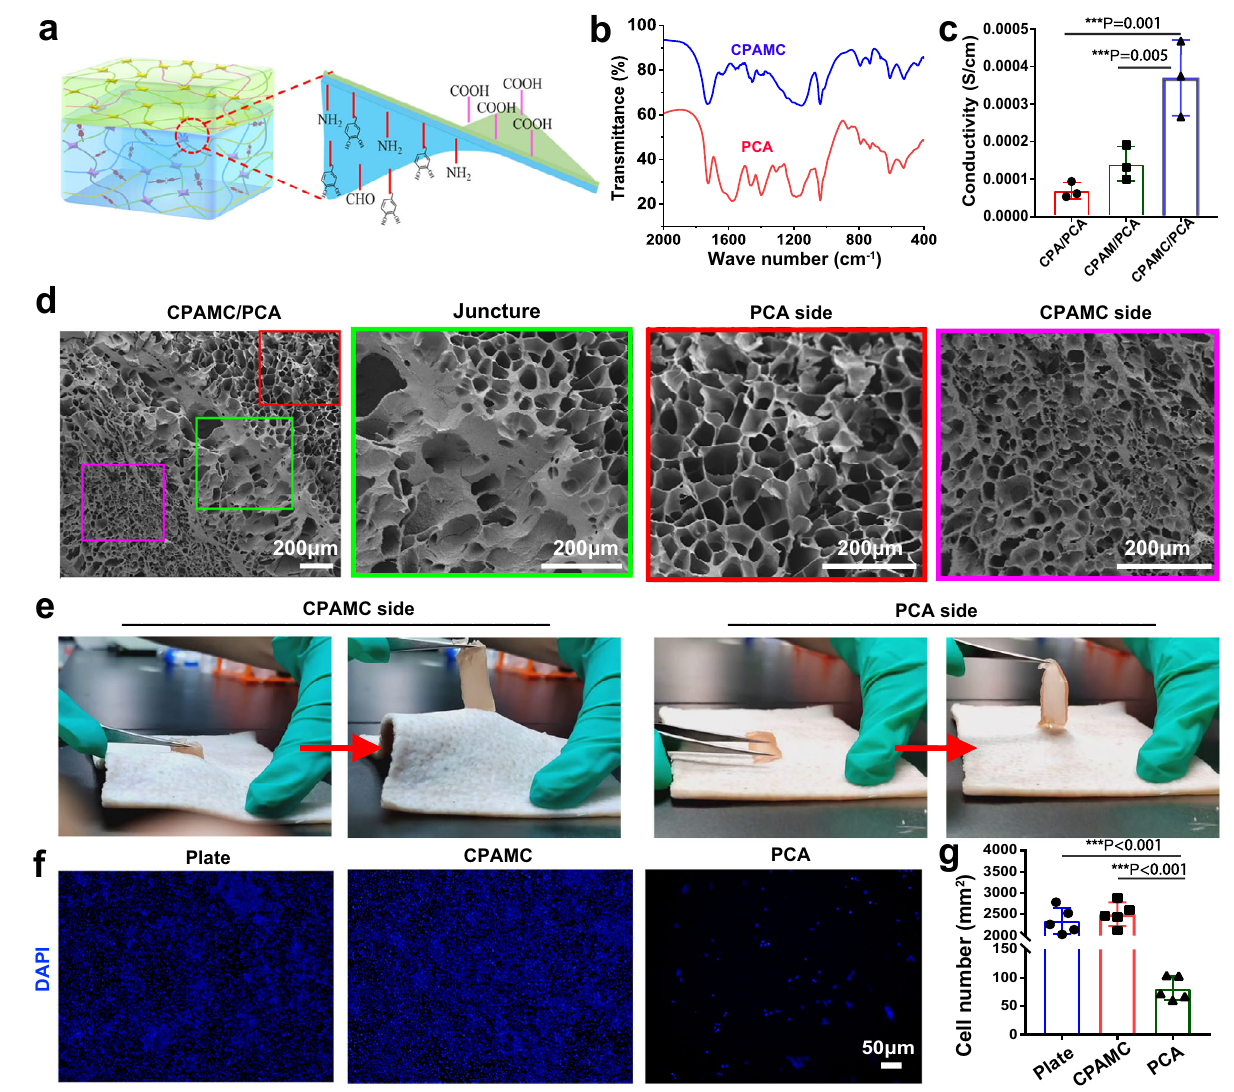
Fig. 4 | Performances test of CPAMC/PCA Janus hydrogel. a Schematic illustra- tion of CPAMC/PCA Janus hydrogel. b The FT-IR of CPAMC hydrogel and PCA hydrogel. c The conductivity analysis of CPA/PCA, CPAM/PCA, and CPAMC/PCA Janus hydrogel (error bar means the standard deviation, * p <0.05, ** p <0.01, *** p <0.001, p value was generated by one ‐ way analysis of variance (ANOVA), fol- lowed by Tukey ’ s multiple ‐ comparison post hoc test, n =3 independent